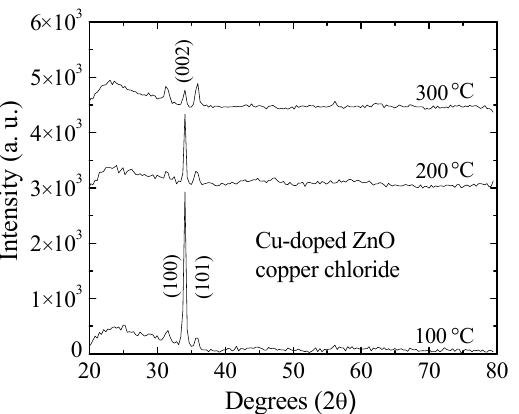
Figure 7. XRD patterns of Cu-doped ZnO post-sensed films prepared from six dips in copper chloride at different operating temperatures.